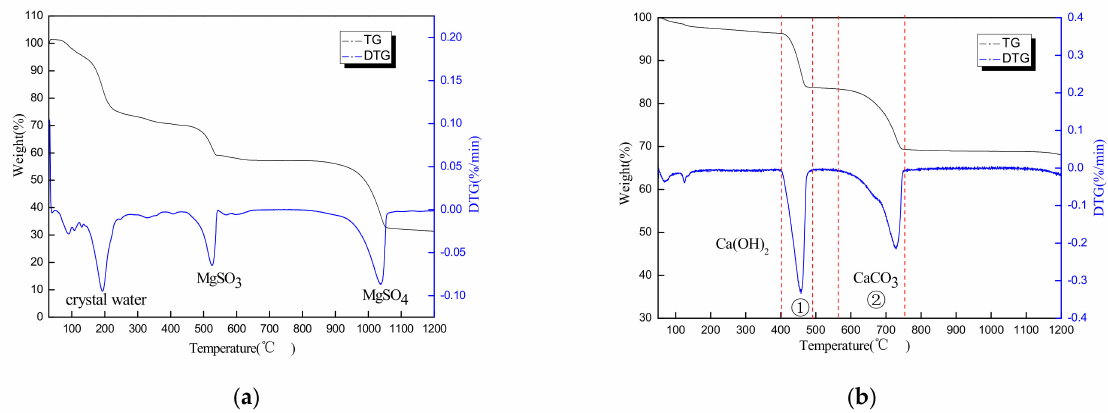
Figure 2. TG − DTG outputs of raw materials: ( a ) magnesium desulfurization slag; ( b ) carbide